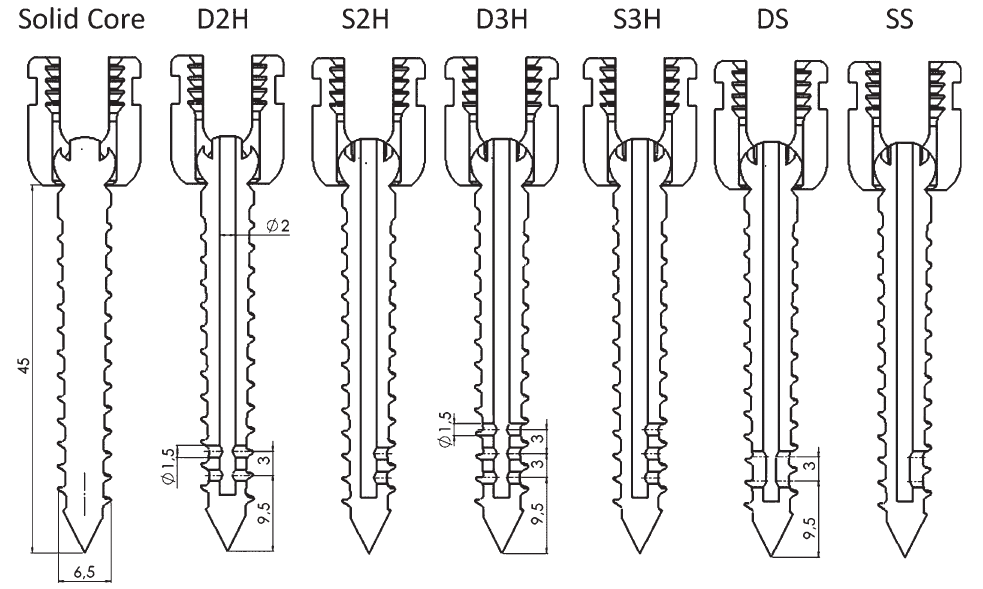
Fig. 1. Design parameters of cannulated